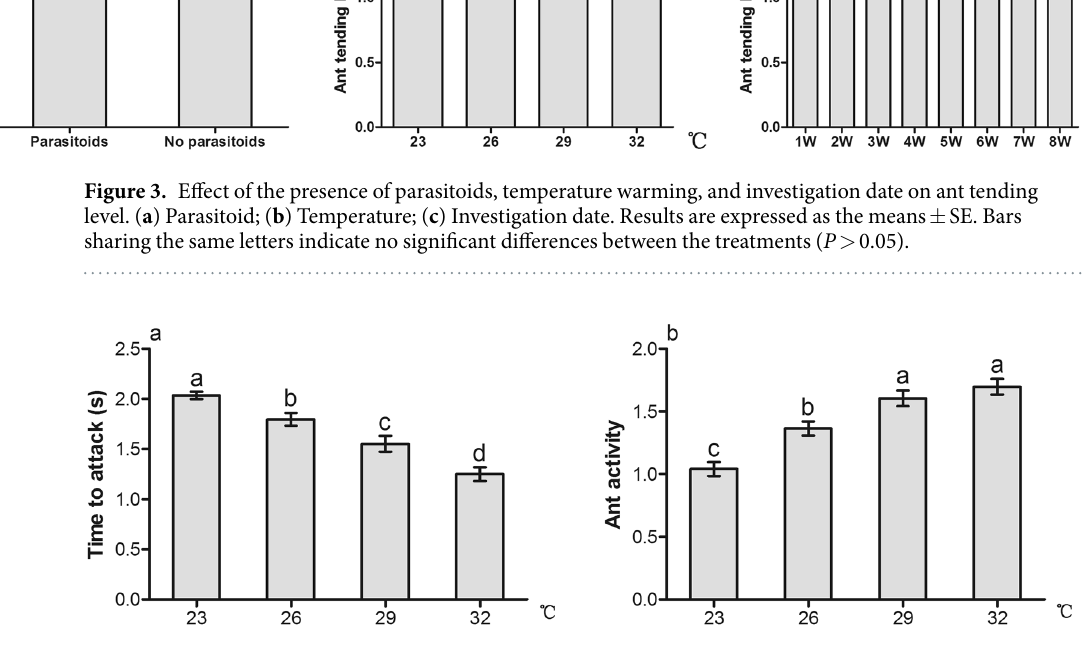
Figure 4. Effect of temperature warming on ants attacking ladybeetles. Results are expressed as the means ± SE. Bars sharing the same letters indicate no significant differences between the treatments ( P > 0.05).